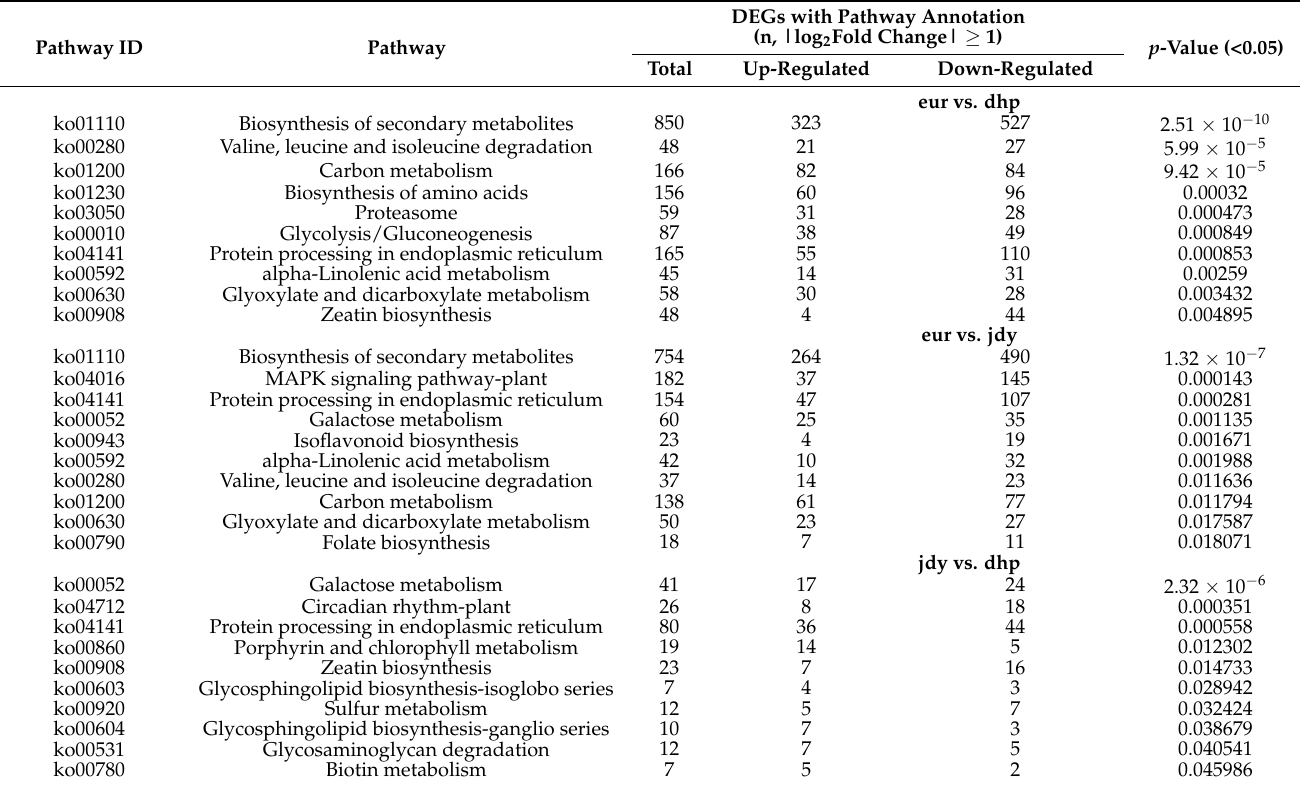
Table 2. Significantly enriched pathways of DEGs among three chestnut